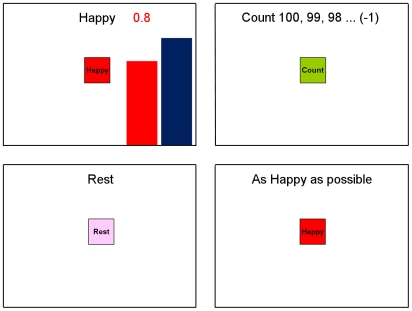
Real-time Display Screens for the Real-time fMRI Neurofeedback Procedure.Visual cues (i.e. text, color bars, and icons) were presented for each of the experimental conditions. During the Happy Memories condition, the word “Happy”, two color bars, and a number indicating the neurofeedback fMRI signal level were displayed on the screen. The participants were instructed to evoke happy autobiographical memories to make themselves feel happy while trying to increase the level of the red bar to a given target level (indicated by the fixed height blue bar). During the Count condition, the subjects saw the cue with a counting instruction, e.g. “Count 100, 99, 98 … (−1)”, and were instructed to mentally count backwards from 100 by subtracting a given integer number (shown in parentheses). During the Rest condition, the participants saw the cue “Rest” and were asked to relax while looking at the screen. For the Happy Memories condition without neurofeedback, no bars were displayed, and the cue “As Happy as possible” was presented instead.